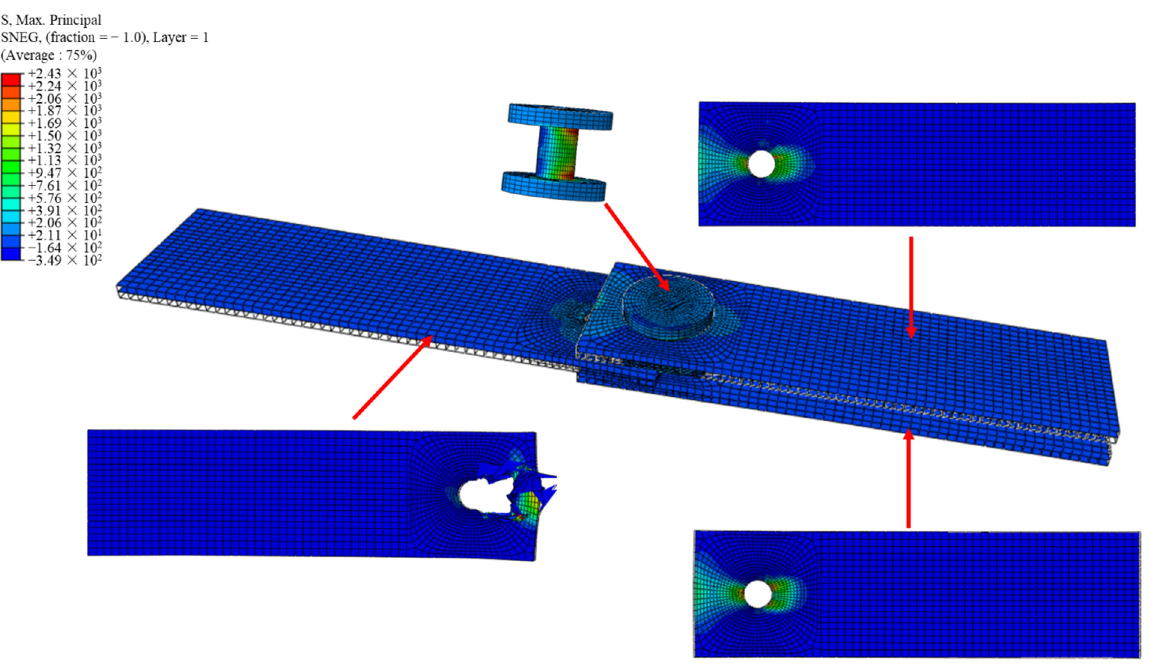
Figure 12. Maximum principal stress cloud of double − lap shear test of GFRP bolted joints .